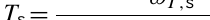
Fig. 1a is smaller than the probability mass of the dark